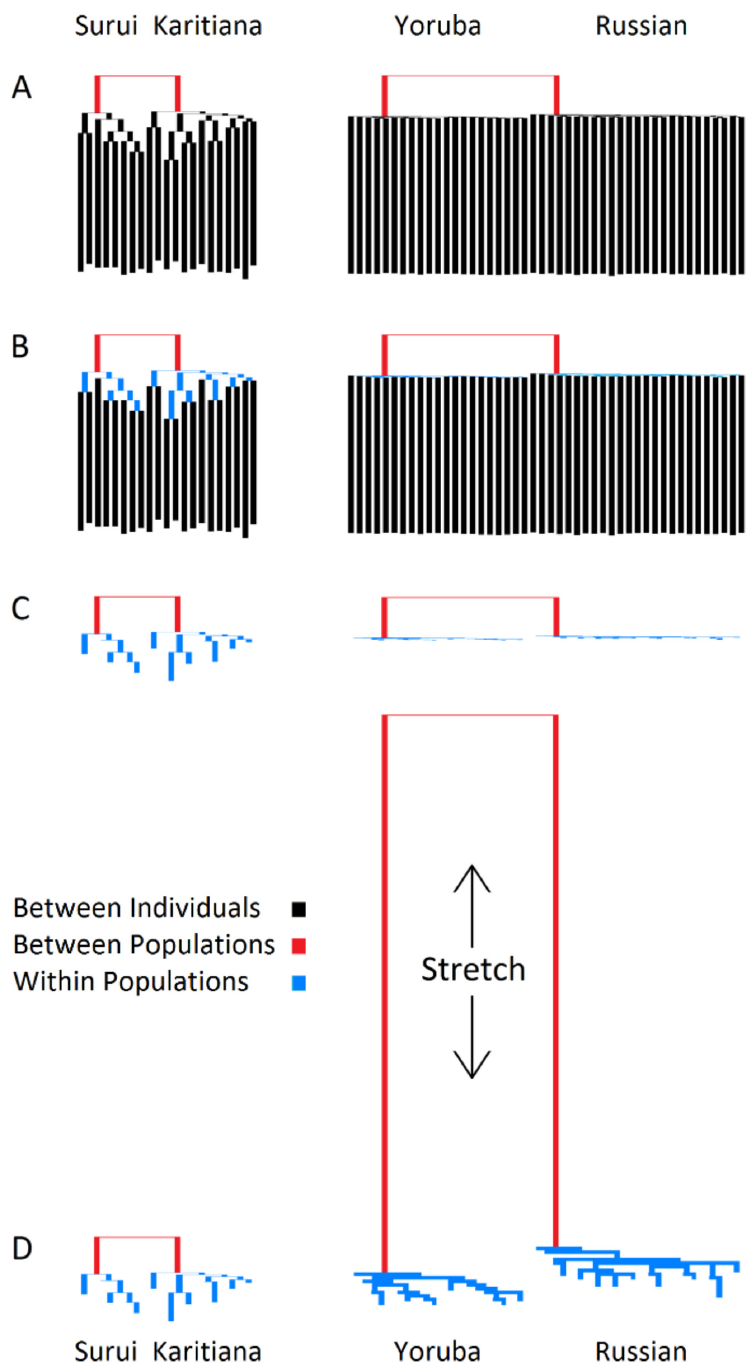
Fig 6. Surui-Karitiana vs. Yoruba-Russian NJ trees of individual similarities. (A) Diversity is apportioned into individual (black) and population (red) components. (B) A third component, structure within populations (blue), is added. (C) The individual component is removed. (D) The Yoruba-Russian tree is stretched to roughly match the level of structure within the Surui-Karitiana tree.